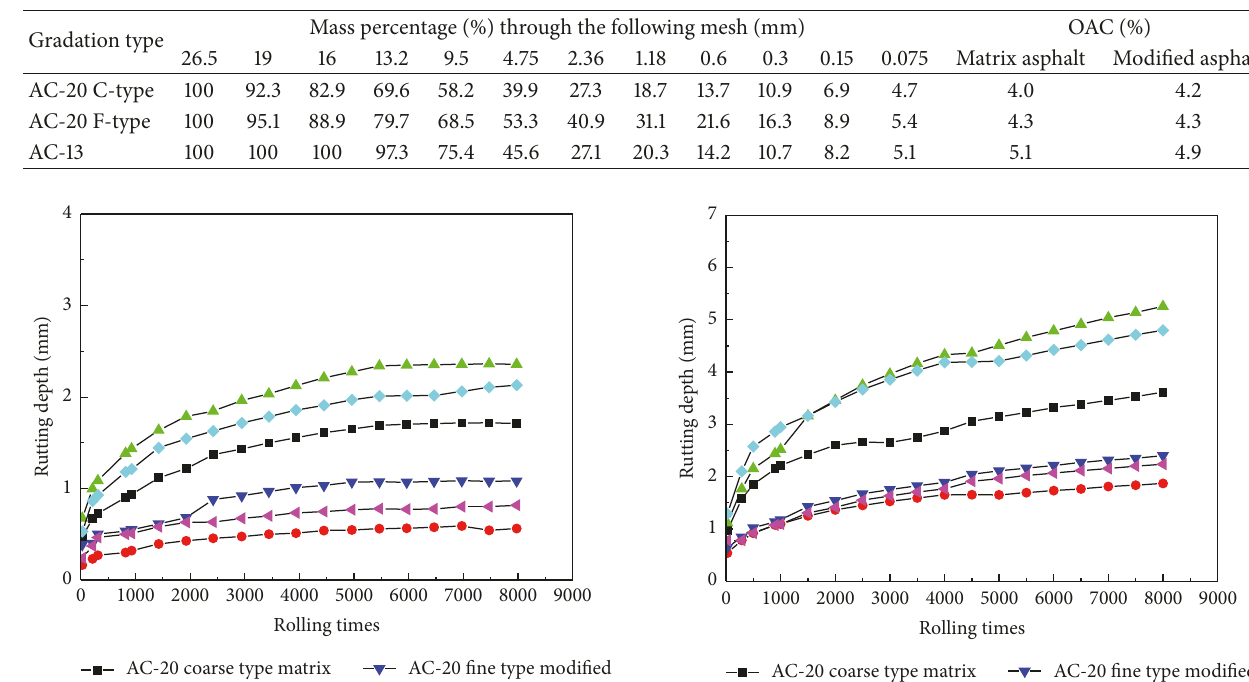
Table 3: Design gradations and optimal asphalt contents of asphalt mixtures.